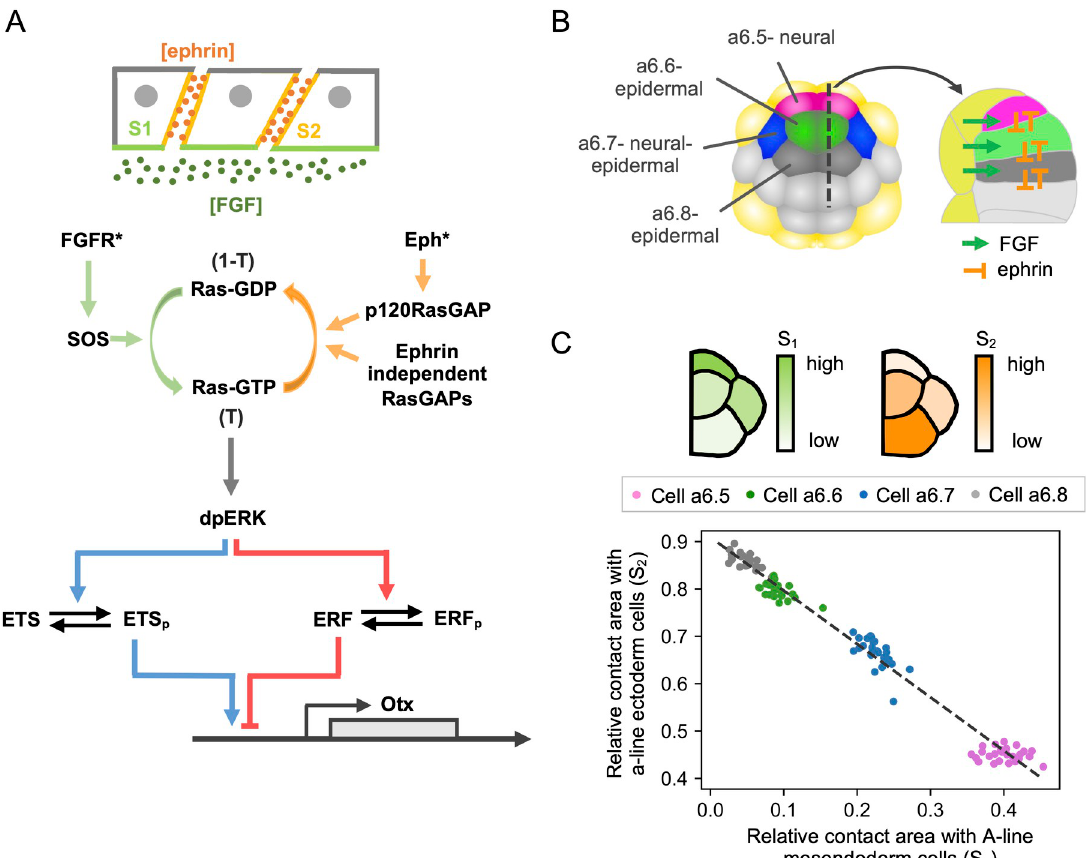
Fig 1. Model presentation. (A) a-line ectoderm cells of the ascidian embryo have different cell contact surfaces with FGF-expressing mesendoderm cells and with ephrin-expressing ectoderm cells. FGF binding activates the FGF receptor. Activated FGF receptors (FGFR � ) then recruits the guanine nucleotide exchange factor SOS, which promotes the conversion of Ras-GDP to Ras-GTP. At the same time, the binding of the ephrin ligand, Efna.d, activates the Eph receptor. The active Eph receptor (Eph � ) in turn recruits p120RasGAP, which promotes the conversion of Ras-GTP to Ras-GDP. Ras-GTP is also converted to Ras-GDP by ephrin-independent RasGAPs. Ras- GTP induces the activation (double phosphorylation: dp) of the extracellular signal-regulated kinase ERK via a kinase cascade including Raf and MEK. Phosphorylation of the ETS1/2 transcription factor by dpERK enhances the expression of the neural marker gene Otx . At the same time, dpERK phosphorylates the Ets repressor factor 2 (ERF2, indicated as ERF in the figure), which inhibits Otx expression. Figure adapted from [8] . (B) Left: Scheme of the 32-cell stage ascidian embryo. a-line ectoderm cells are shown in different colors: a6.5 cell in magenta, a6.6 cell in green, a6.7 cell in blue, and a6.8 cell in gray. Mesendoderm cells are shown in yellow and b-line ectoderm cells in light grey. The dotted line is the line of sagittal section used for the right panel. Right: sagittal section highlighting cell surface contacts between ectoderm and mesendoderm cells and signals considered in the model. Figure adapted from [8]. (C) Top: Scheme of the a-line ectoderm cells, showing in different colors the area of each cell surface in contact with FGF expressing cells (S 1 , on the left) and with ephrin expressing cells (S 2 , on the right). Bottom: Relative area of a-line ectoderm cell surface in contact with A-line mesendoderm cells, S 1 , and ectoderm cells, S 2 , for the four cell types indicated in panel B. The relative contact area is computed as the surface contact /total cell surface. Each dot represents a single cell. Fitting the experimental data with a linear function (shown as a black dashed line), we obtained the expression for the relation between S 1 and S 2 : S 2 = -1.13 S 1 + 0.91 (R 2 = 0.9896). Figure redrawn from